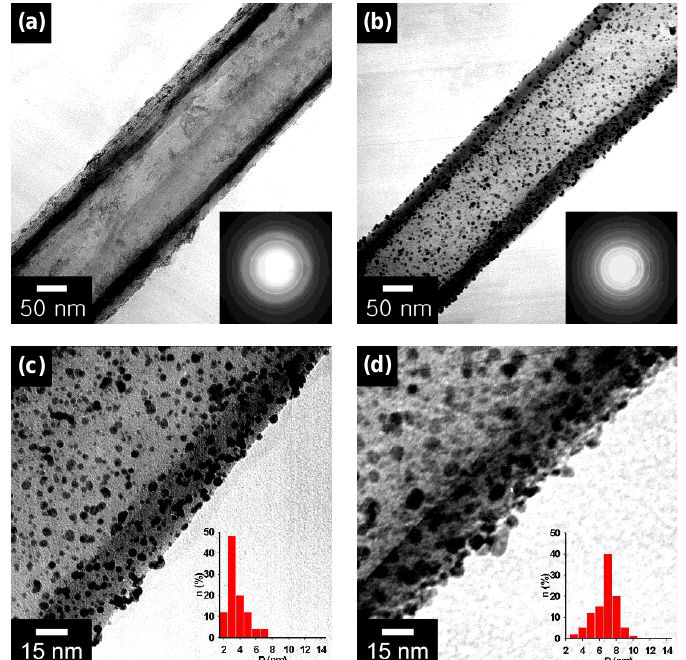
Figure 3. TEM images of ( a ) a MCPPy nanotube and ( b ) a Pd nanoparticles-decorated MCPPy nanotube prepared with a dilute PdCl solution. The inset images are the electron 2 diffraction patterns; (c ) and ( d ) magnified TEM images of Pd nanoparticles-decorated MCPPy nanotubes obtained with the palladium salt concentrations of 10 −4 and 10 −3 M, respectively. The Pd nanoparticle size is illustrated in the inset histogram. With permission from [22]; Copyright 2006, Wiley-VCH Verlag GmbH & Co.